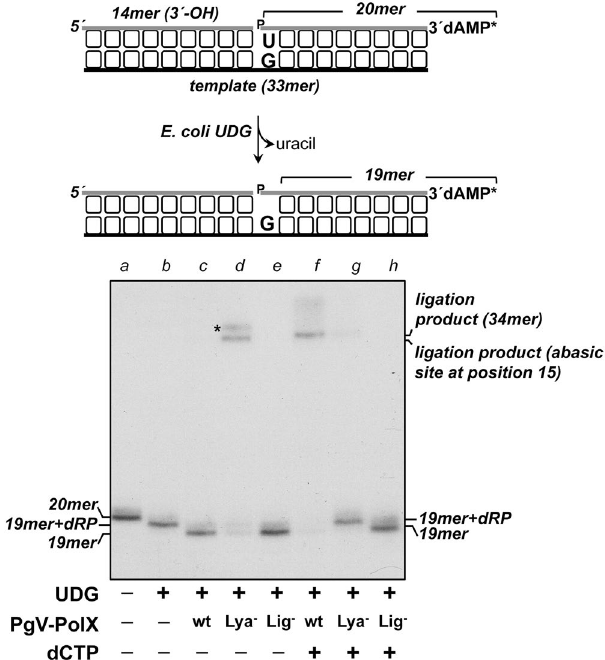
Figure 8. In vitro repair of a single nucleotide BER intermediate. Top, schematic representation of the formation of the BER intermediate used as substrate. The [ 32 P]3 ′ -labeled 2 ′ -deoxyuridine-containing substrate (lane a ) was treated with 27 nM E. coli UDG (lane c ), leaving a 5 ′ -dRP terminus. The resulting BER intermediate (1 nM) was incubated with 3 nM of the indicated PgVPolX in the absence ( − ) or presence ( + ) of 10 µ M dCTP for 10 min at 30 °C, as described in Materials and Methods. Position of products is indicated. Asterisk indicates an electrophoretic artifact that appears specifically with the 34mer product with an AP site at position